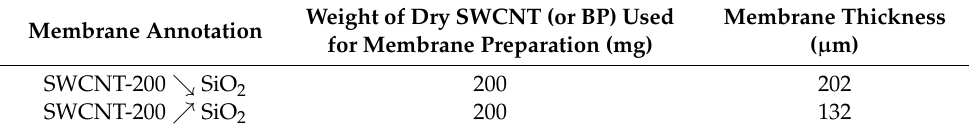
Table 3. SWCNT membranes enriched by SiO 2 .